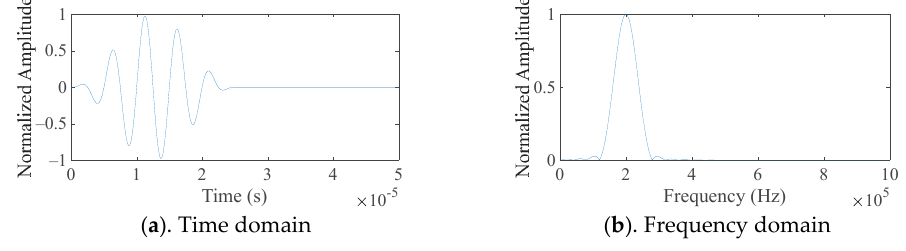
Figure 14. Excitation Signal Centered at 200 kHz.